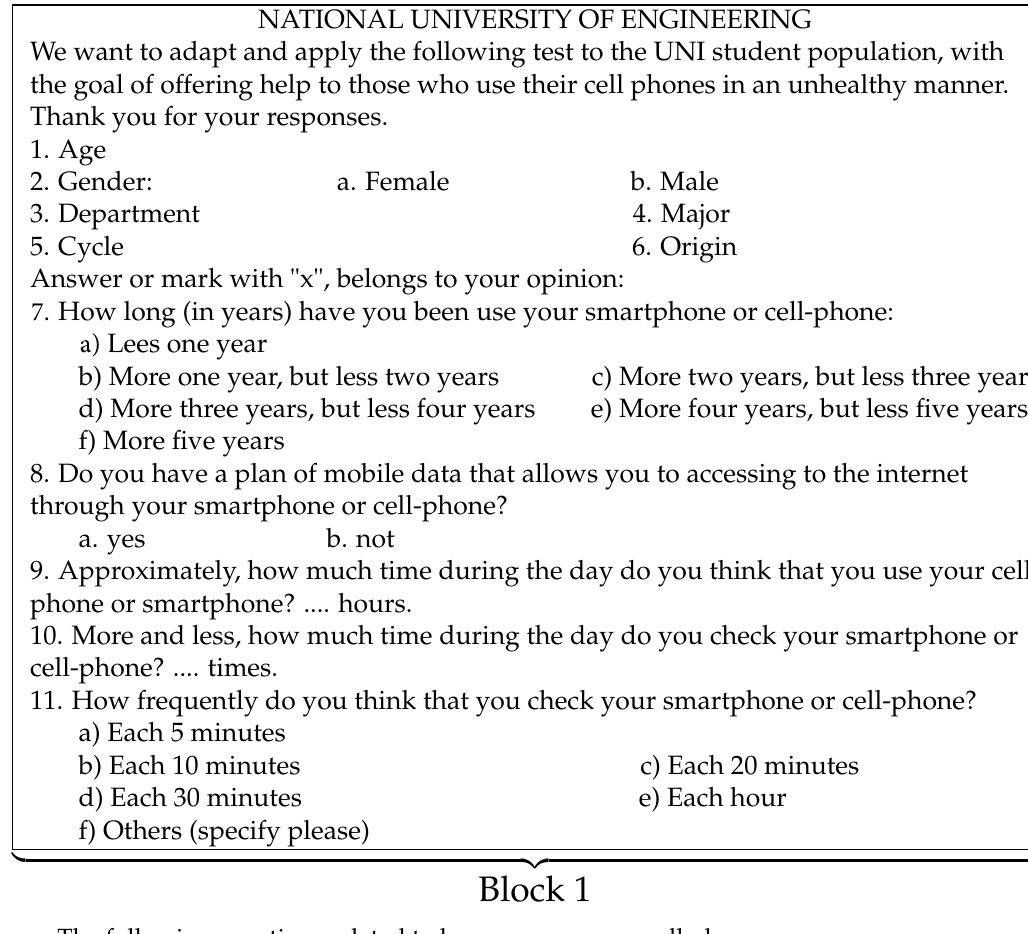
NATIONAL UNIVERSITY OF